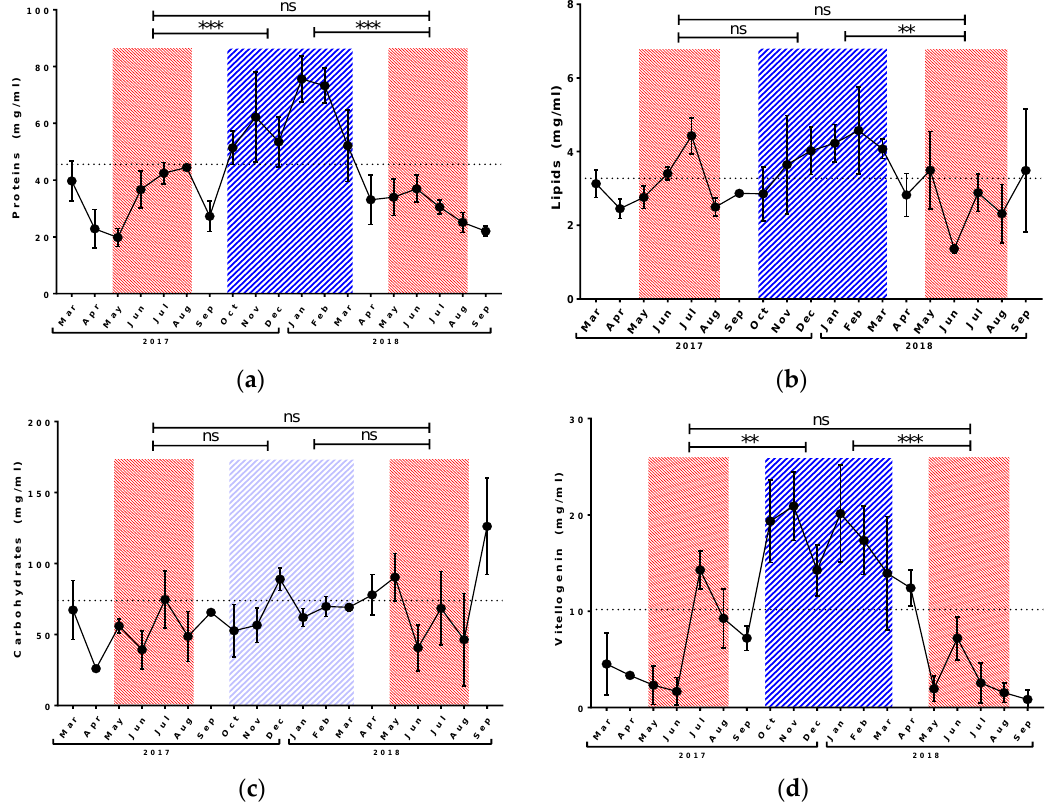
Figure 1. Seasonal development of total protein ( a ), lipid ( b ), and carbohydrate ( c ) concentration and level of vitellogenin ( d ) in honey bee haemolymph. Red striped areas indicate summer generations of honey bees (May – August), and blue area indicates winter generations (October – March). Dots represent mean ± SD, n = 3 – 5. Dotted line represents annual average (October 2017 – September 2018). Asterisk indicates significant difference ** p < 0.01, *** p < 0.001, ns = not significant.